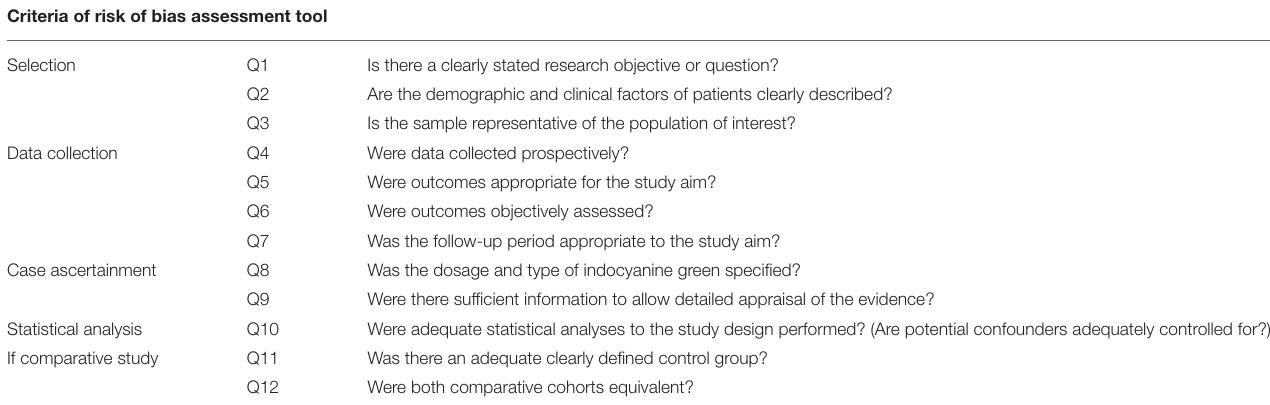
TABLE 1 | Risk of bias assessment